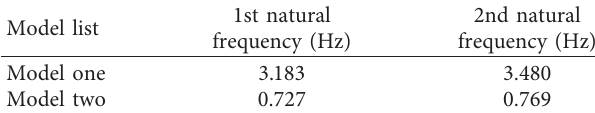
Table 3: The first two natural frequencies of two models. Model